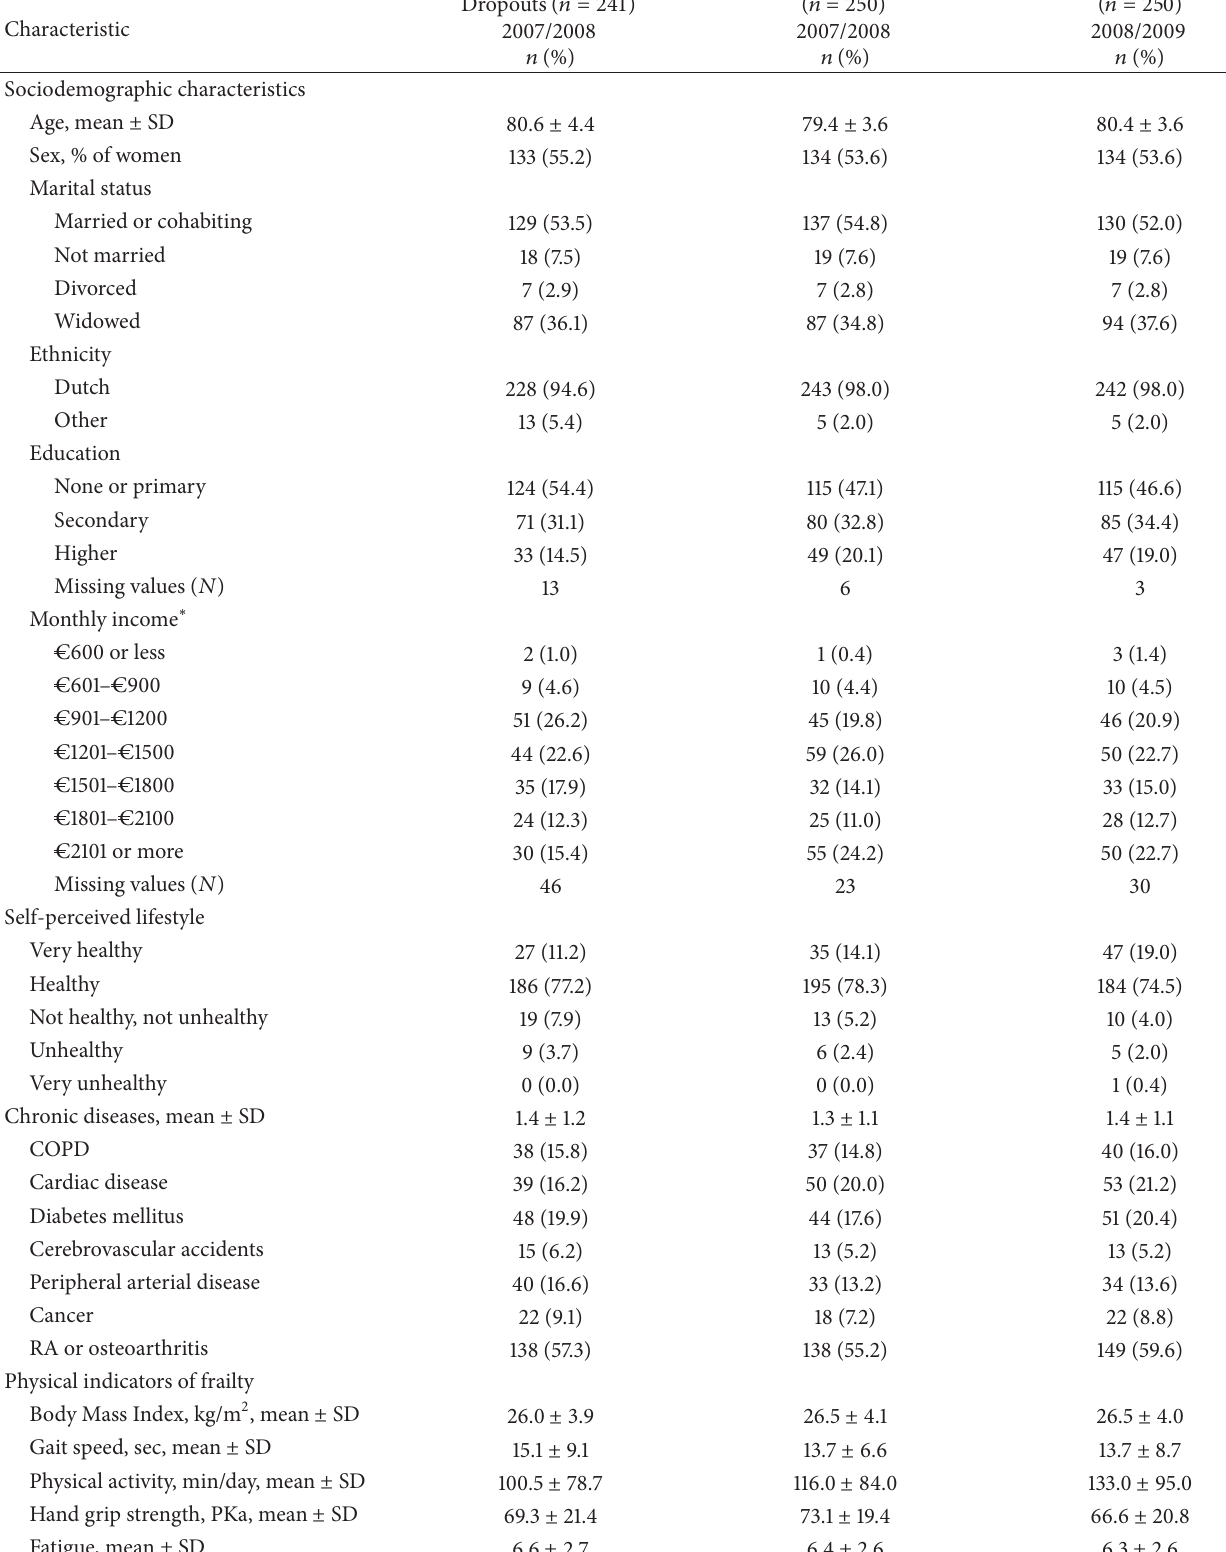
Table 2: Characteristics of respondents (2007/2008, 𝑁 = 491 ; 2008/2009, 𝑁 = 250 ) 1